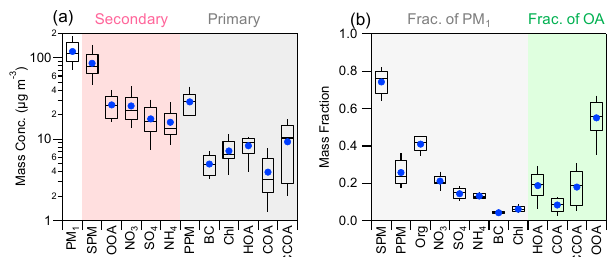
Figure 6. Box plots of (a) mass concentrations and (b) mass frac- tions of aerosol species for 9 pollution events marked in Fig. 1. The mean (blue circles), median (horizontal line), 25th and 75th per- centiles (lower and upper box), and 10th and 90th percentiles (lower and upper whiskers) are shown for each box.